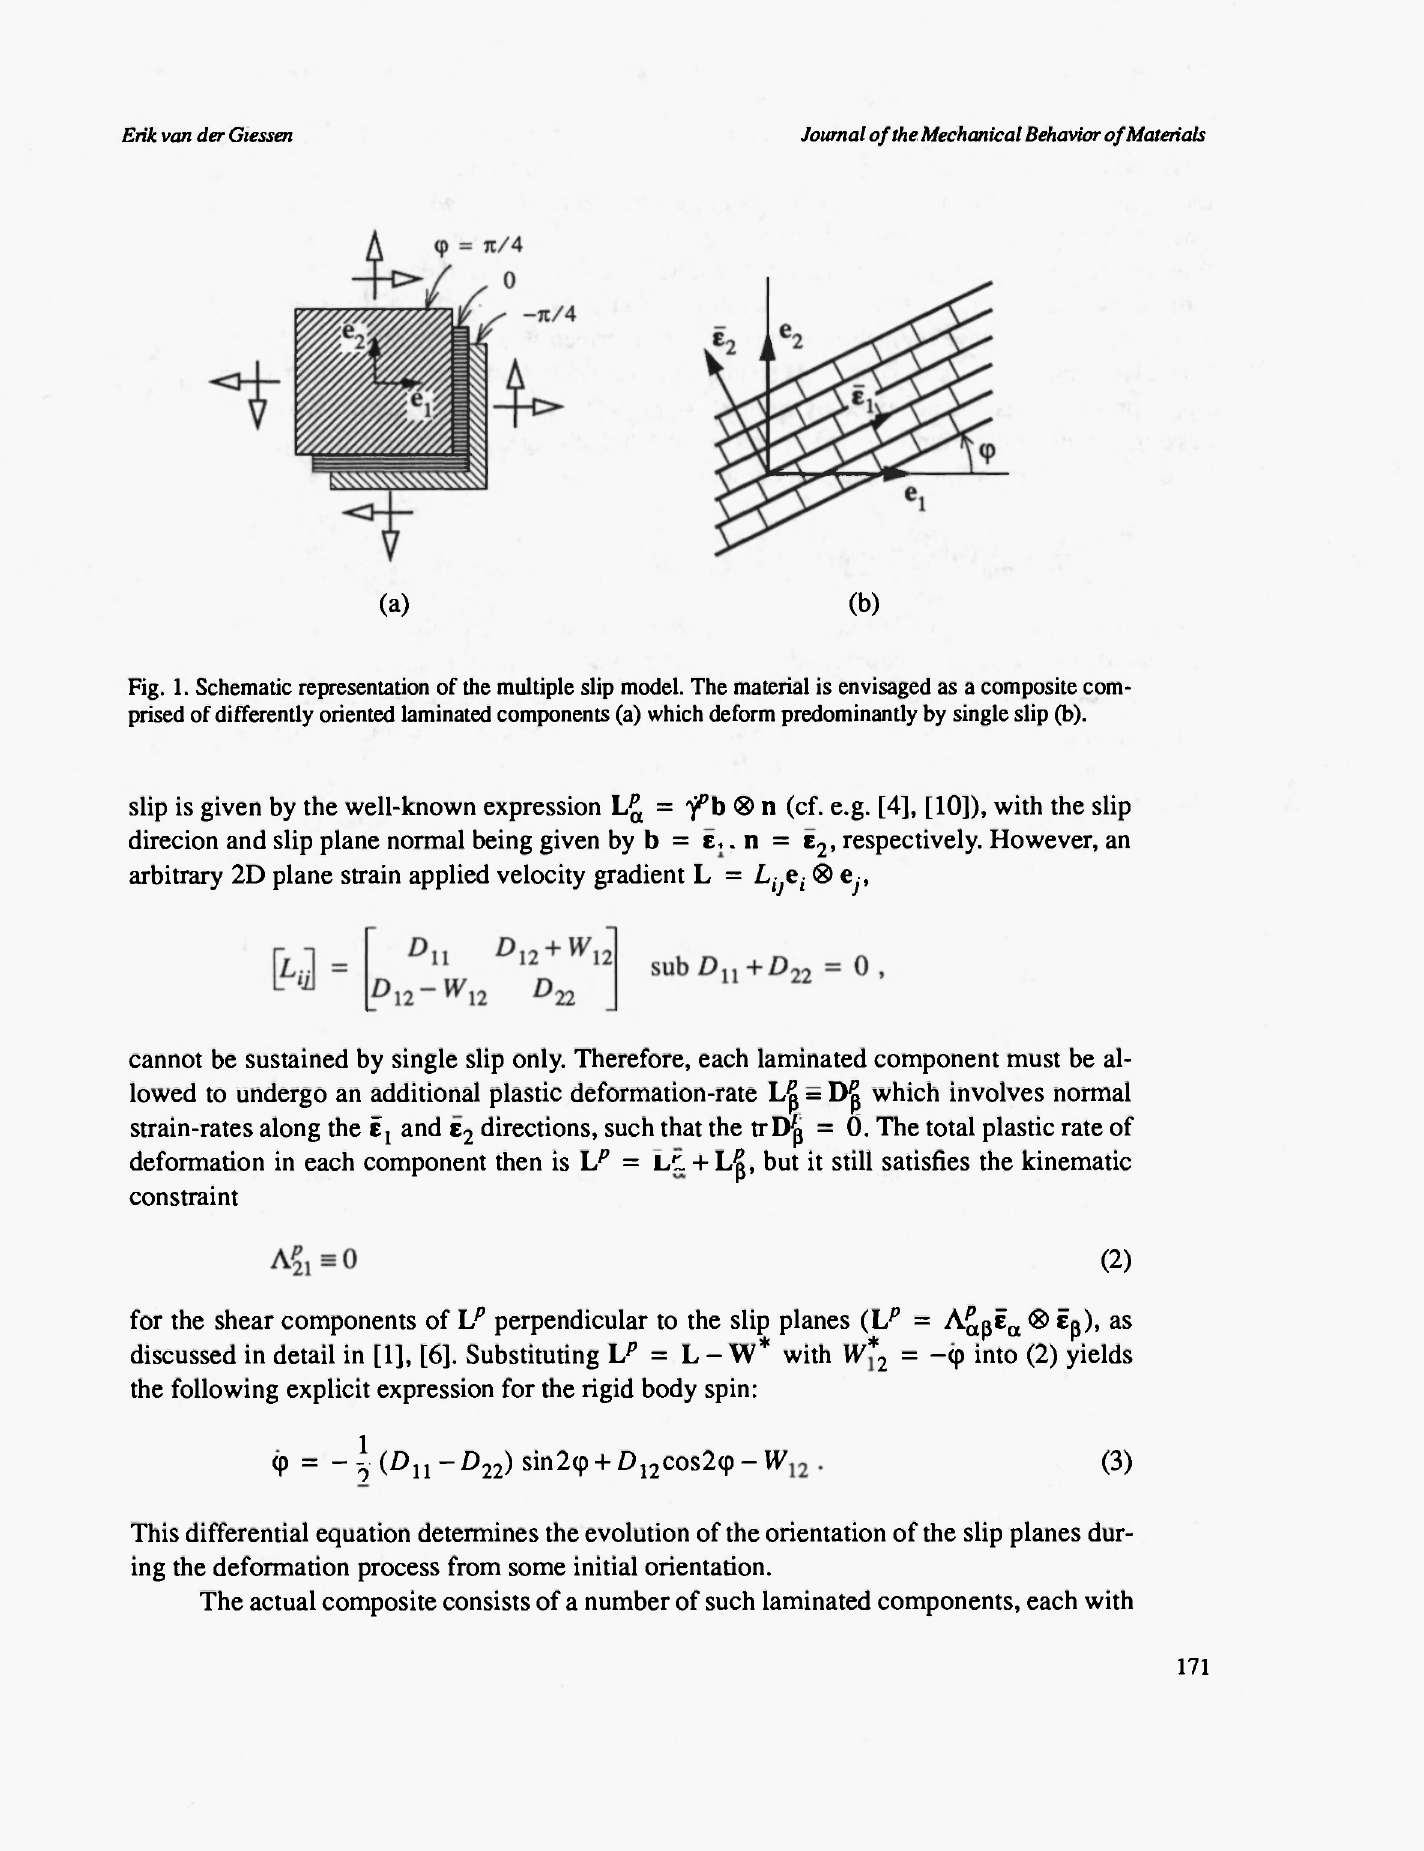
Fig. 1. Schematic representation of the multiple slip model. The material is envisaged as a composite com- prised of differently oriented laminated components (a) which deform predominantly by single slip (b).